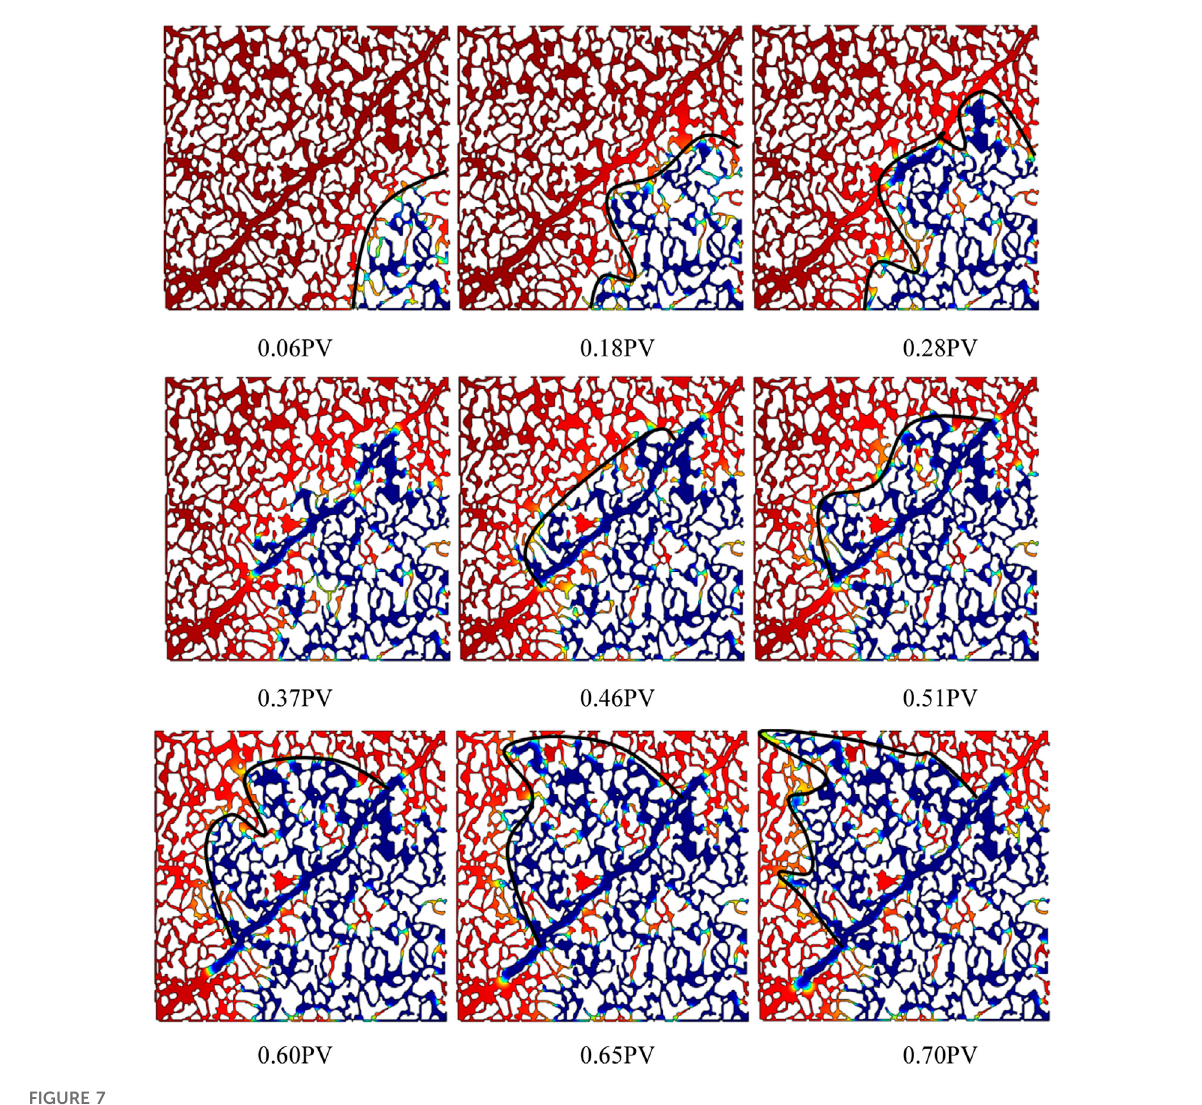
FIGURE 7 Water drive front of the parallel fracture